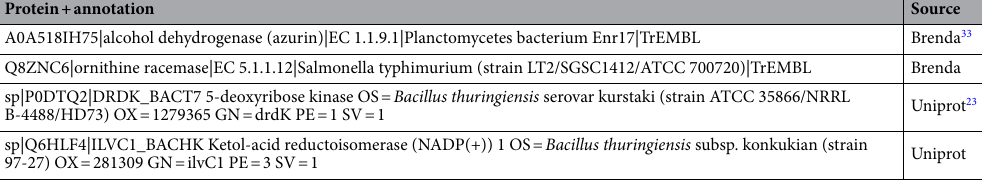
Table 2. Proteins with known functions other than pore formation that were correctly categorized by the model as not being pore